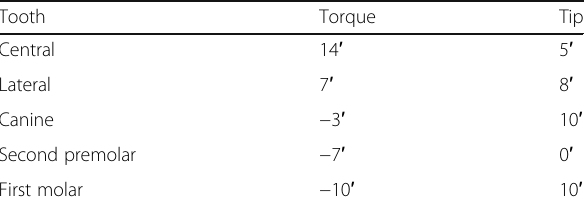
Table 1 Tip and torque of the teeth